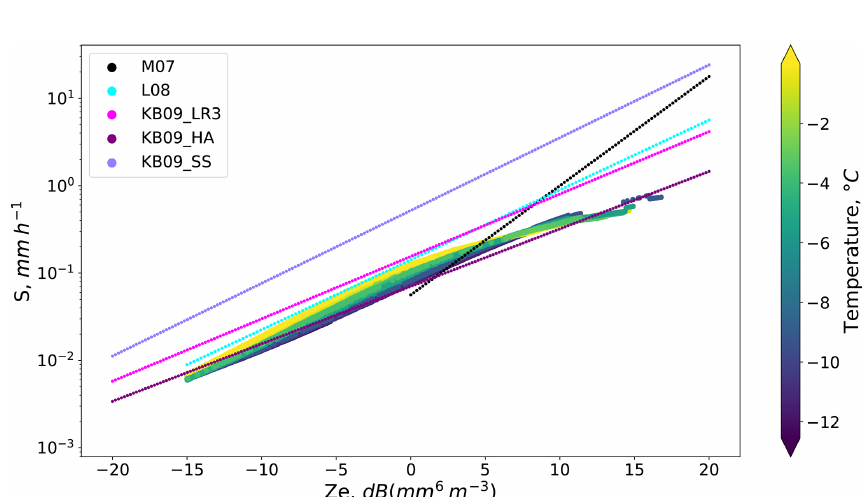
Figure 7. Z – S values as a function of temperature for this retrieval compared against those from M07, Matrosov (2007); L08, Liu (2008); and KB09_LR3, KB09_HA, and KB09_SS, Kulie and Bennartz